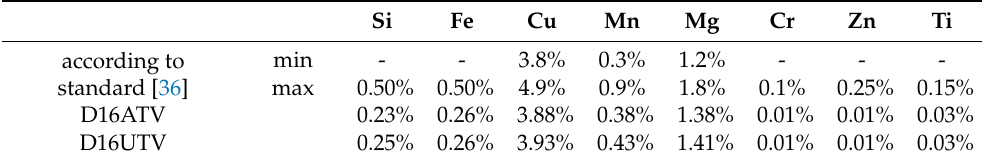
Table 2. The content of main chemical components (apart from aluminum) of D16ATV and D16UTV alloys (wt %).